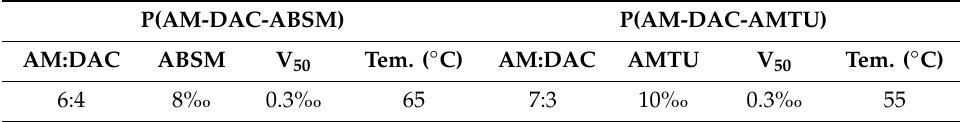
Table 1. The optimum synthesis conditions for P(AM-DAC-ABSM) and P(AM-DAC-AMTU).